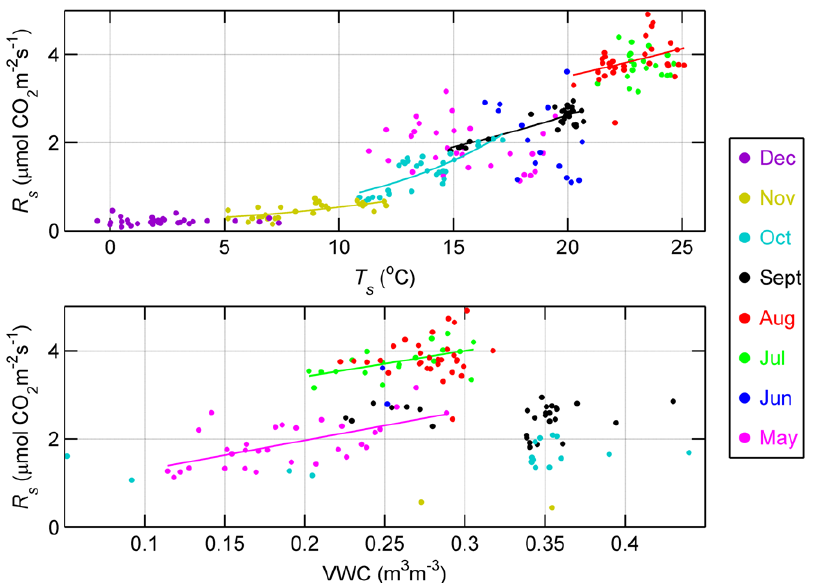
Figure 4. Seasonal relationships between soil respiration ( R s ) and soil temperature ( T s ) at 10 cm depth and soil water content (VWC) for each month in 2008. Data points were mean daily values.